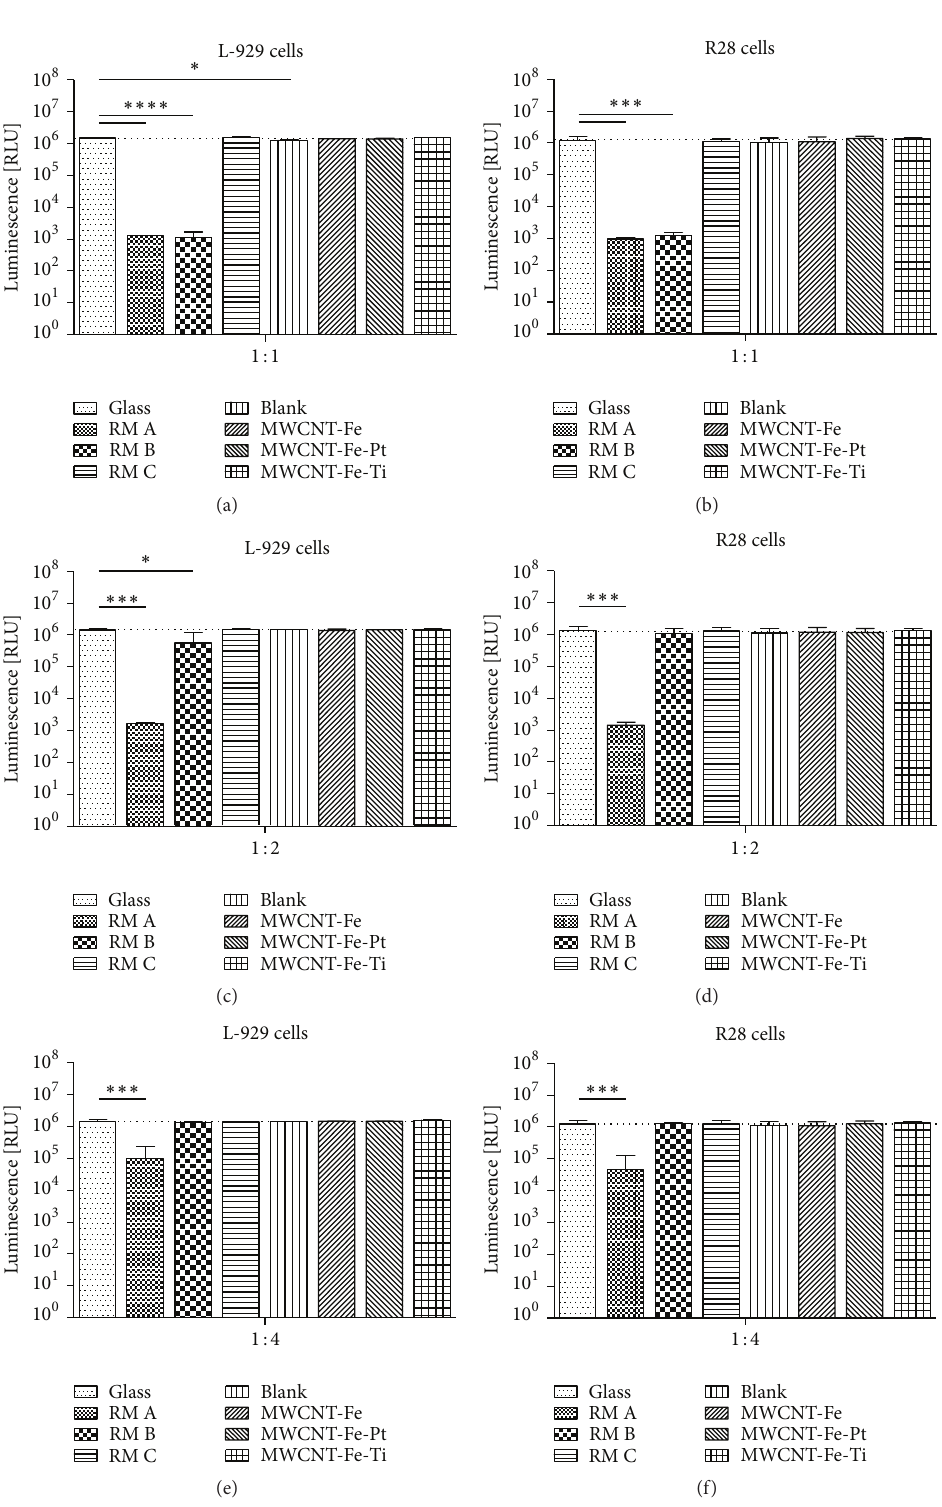
Figure 2: Effects of extractive media on cell survival. Analysis of cell viability in cultures of L-929 cells ( 𝑛 = 2 individual experiments) and R28 cells ( 𝑛 = 4 individual experiments) incubated for 24 hours with increasing serial dilutions of extractive media obtained from different wafer slices (blank, MWCNT-Fe, MWCNT-Fe-Pt, and MWCNT-Fe-Ti) and certified positive (RM A, RM B) and negative (RM C) reference materials. Extractive medium without the incubation of any material (glass) was used as internal negative control; its mean values are marked by the dotted lines. Data are represented as mean ± SD. They were compared to the glass control and analyzed using unpaired two-tailed 𝑡 test. (a) ∗∗∗∗ 𝑃 < 0.0001 , RM A and RM B; ∗ 𝑃 = 0.0243 , blank. (b) ∗∗∗ 𝑃 = 0.0010 , RM A and RM B. (c) ∗∗∗ 𝑃 = 0.0002 , RM A; ∗ 𝑃 = 0.0476